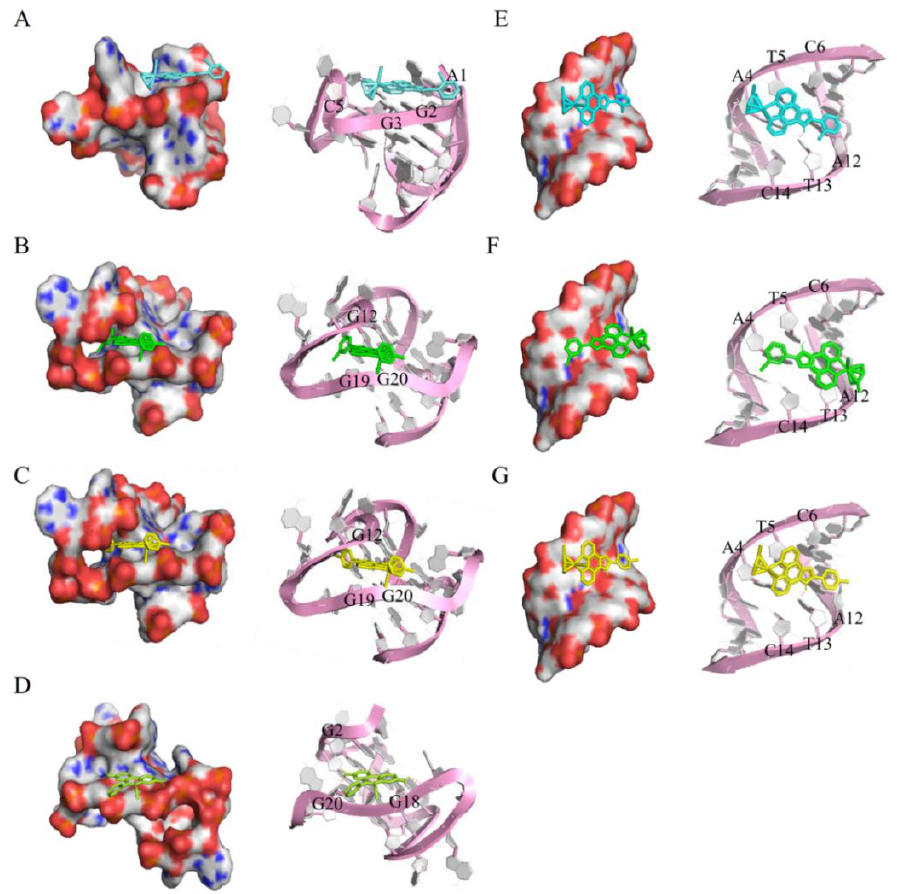
Figure 4. Binding mode of 1 ( A ), 2 ( B ), 3 ( C ), and EB ( D ) with KRAS G-quadruplex DNA and dsDNA ( E – G ) calculated by molecular docking.